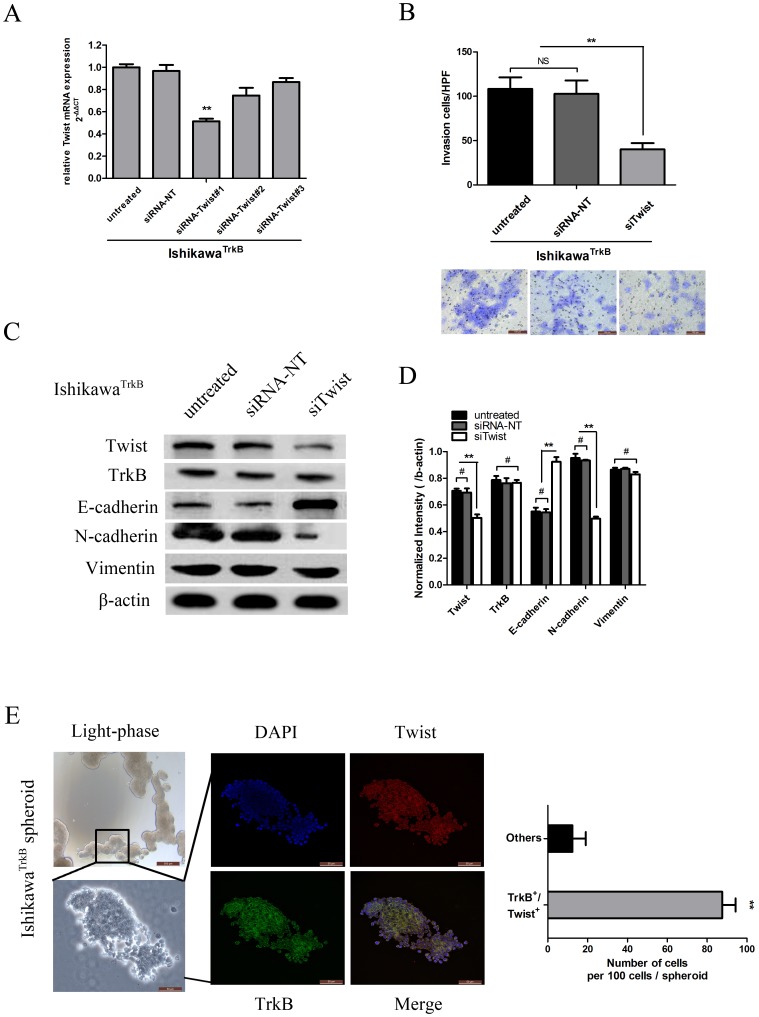
Twist is required for TrkB-induced EMT-like transformation and anoikis suppression.A: Quantification was performed to determine the relative change in Twist mRNA expression following transfection of IshikawaTrkB cells with control (siRNA-NT) or siRNA-Twist oligonucleotide duplexes. SiRNA-Twist#1 was chosen for further study (**p<0.01). B. Invasion ability was significantly decreased in IshikawaTrkB cells transfected with siRNA-Twist compared to untreated cells or cells transfected with siRNA-NT as assessed by transwell assay(**p<0.01; NS, not significant), Bars show mean ± SD. (Below, 200×). C. Protein levels of Twist, TrkB and EMT markers as analyzed by immunoblotting in IshikawaTrkB cells (Left), and further quantified by densitometry of triplicate blots (Right, **p<0.01; #, not significant). β-actin was included as an internal control. E. Surviving IshikawaTrkB cell spheroids in suspension culture (Left, upper: 40×, below: 400×). After adhering for 4 h on glass coverslips, spheres were immunostained with antibodies against Twist (red) and TrkB (green). In the merged images (bottom right), these spheres contain double-positive cells (400×). Quantification of these cell aggregates formed by surviving IshikawaTrkB cells showed a higher number of TrkB+/Twist+ cells than non-expressing cells (Right panel). The data are reported as mean ± SD (**p<0.01). All experiments were carried out in triplicate and repeated at least three times.